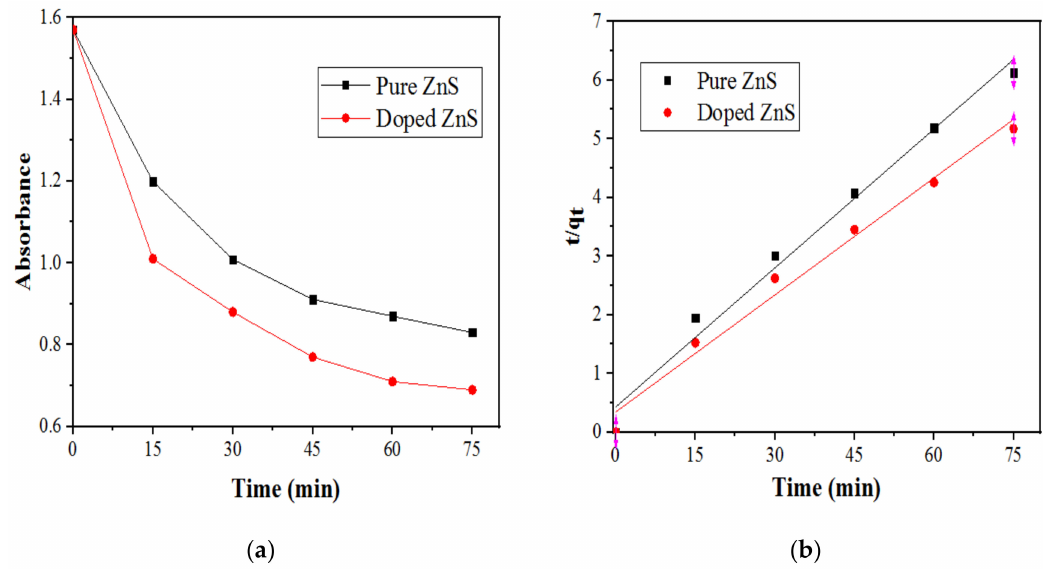
Figure 8. ( a ) SDB absorbance changes at the maximum wavelength ( λ max = 560 nm) and ( b ) the kinetic model for the photodegradation in the presence of pure and Mn 2+ :ZnS Qds under optimum conditions (15 mL of 70 ppm SDB, pH 6, 75 min irradiation, 40 mg Qds).